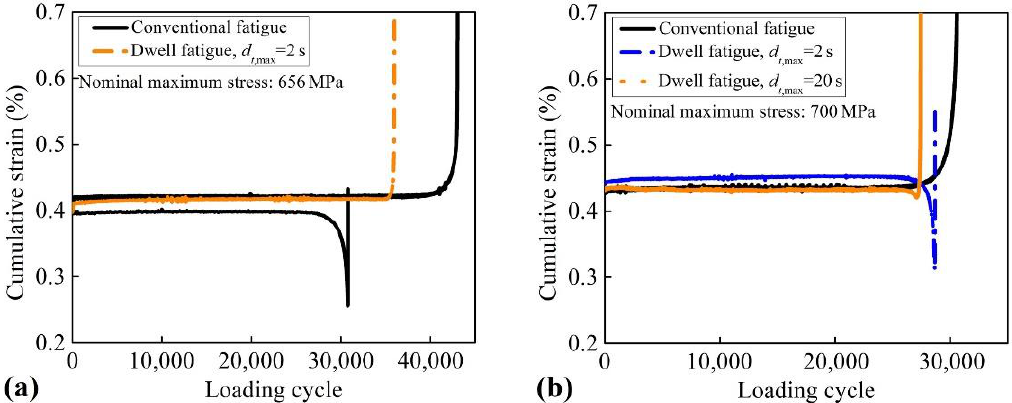
Figure 10. Variation in cumulative maximum strain with the number of loading cycles for notched specimens under conventional fatigue and dwell fatigue tests. ( a ): fatigue test at the nominal maximum stress σ max = 656 MPa; ( b ): fatigue test at the nominal maximum stress σ max = 700 MPa.